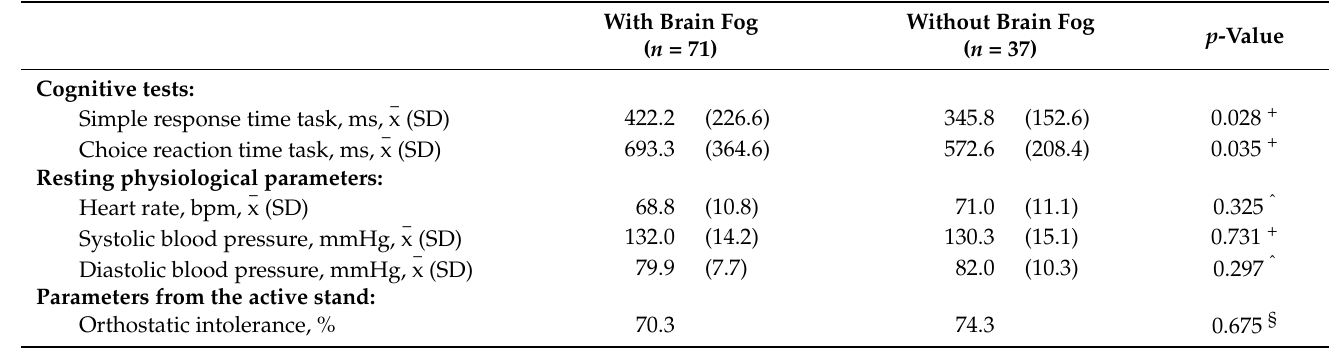
Table 4. Comparisons of computer-based cognitive tasks and orthostatic active stand parameters between participants with and without brain